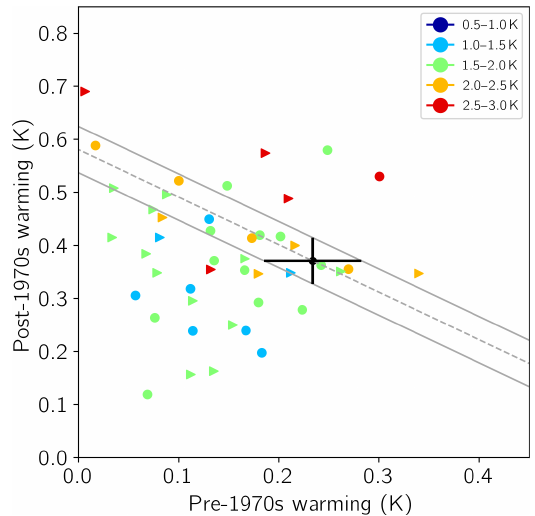
Figure 14. Post-1970s warming (surface temperature change be- tween the 1970–1990 and 1994–2005 periods) versus pre-1970s warming (surface temperature change between the 1900–1939 and 1940–1969 periods), with plot symbols colored by TCR bins shown in the legend. Circles represent CMIP5 models, and right-facing tri- angles represent CMIP6 models. Observational pre- and post-1970s warming is plotted as a black circle with uncertainty as black lines. Solid gray lines represent the outer bounds of pre- and post-1970s warming, summing to total observed